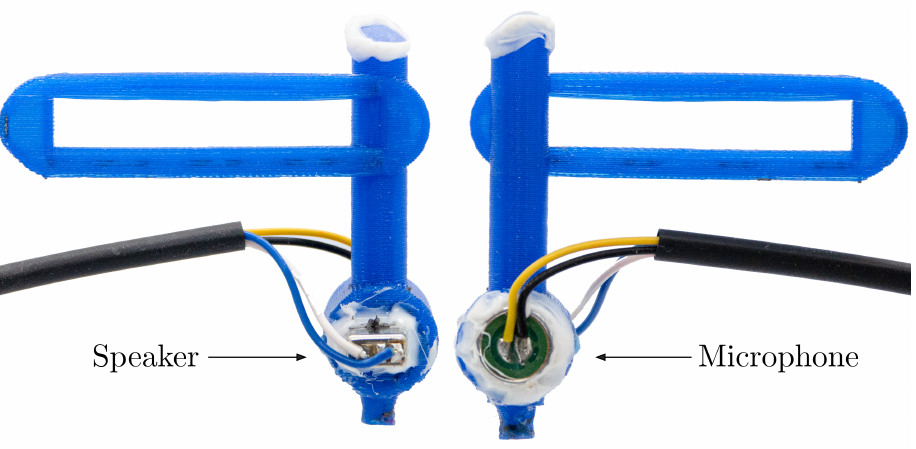
Figure 4. Detailed illustration of the pipette, where both sides are shown. Speaker and microphone are mounted face to